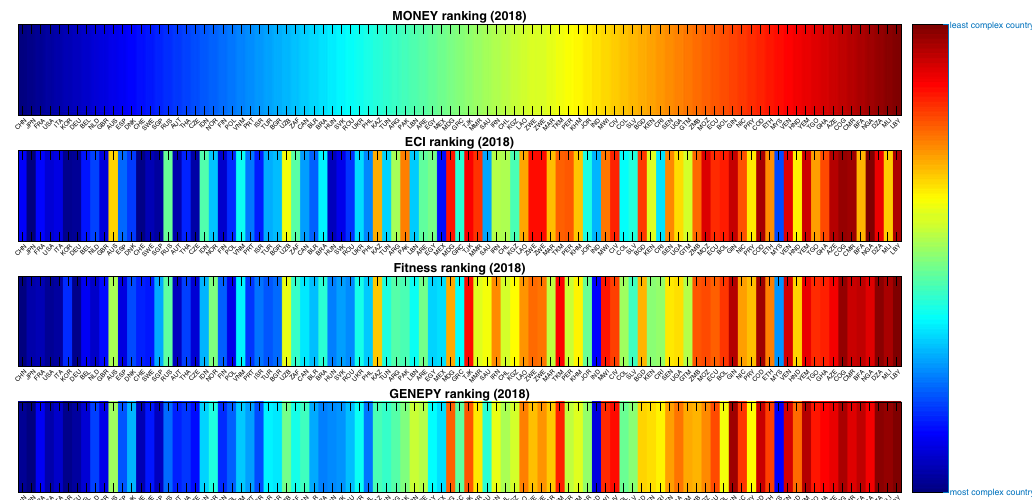
Figure 4. Comparison table for various country complexity indices in 2018 (HS-4 level).